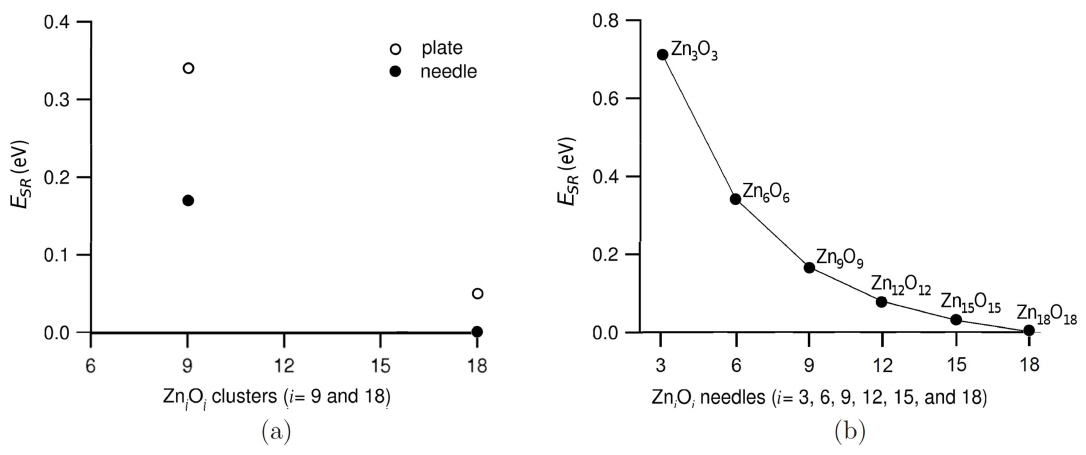
Figure 2. Scaled relative energies ( E ( a ) plate and needle clusters; and ( b ) different length Zn 15, and 18. (The line connecting data points in ( b ) is simply a guide to the eye.) To obtain the scaled relative energy, the energy relative to the lowest energy conformer was divided by the number of atoms in the